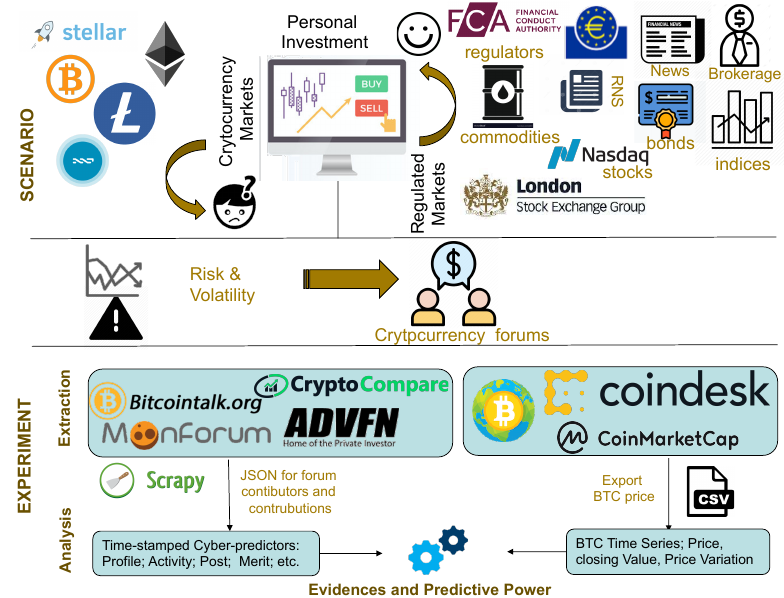
Figure 1. Overview of the